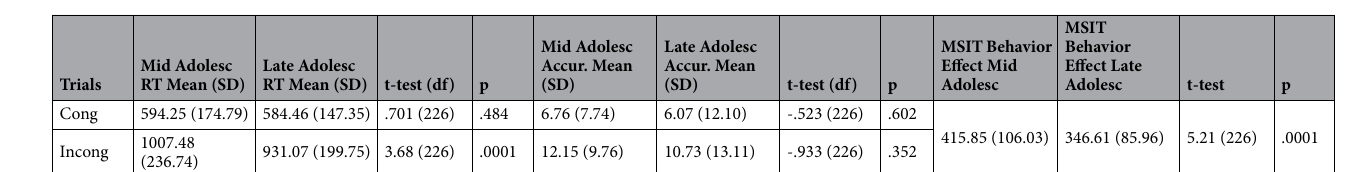
Table 3. Longitudinal comparison of reaction time and accuracy between mid-adolescence and late- adolescence. See Fig. 5 for more information.